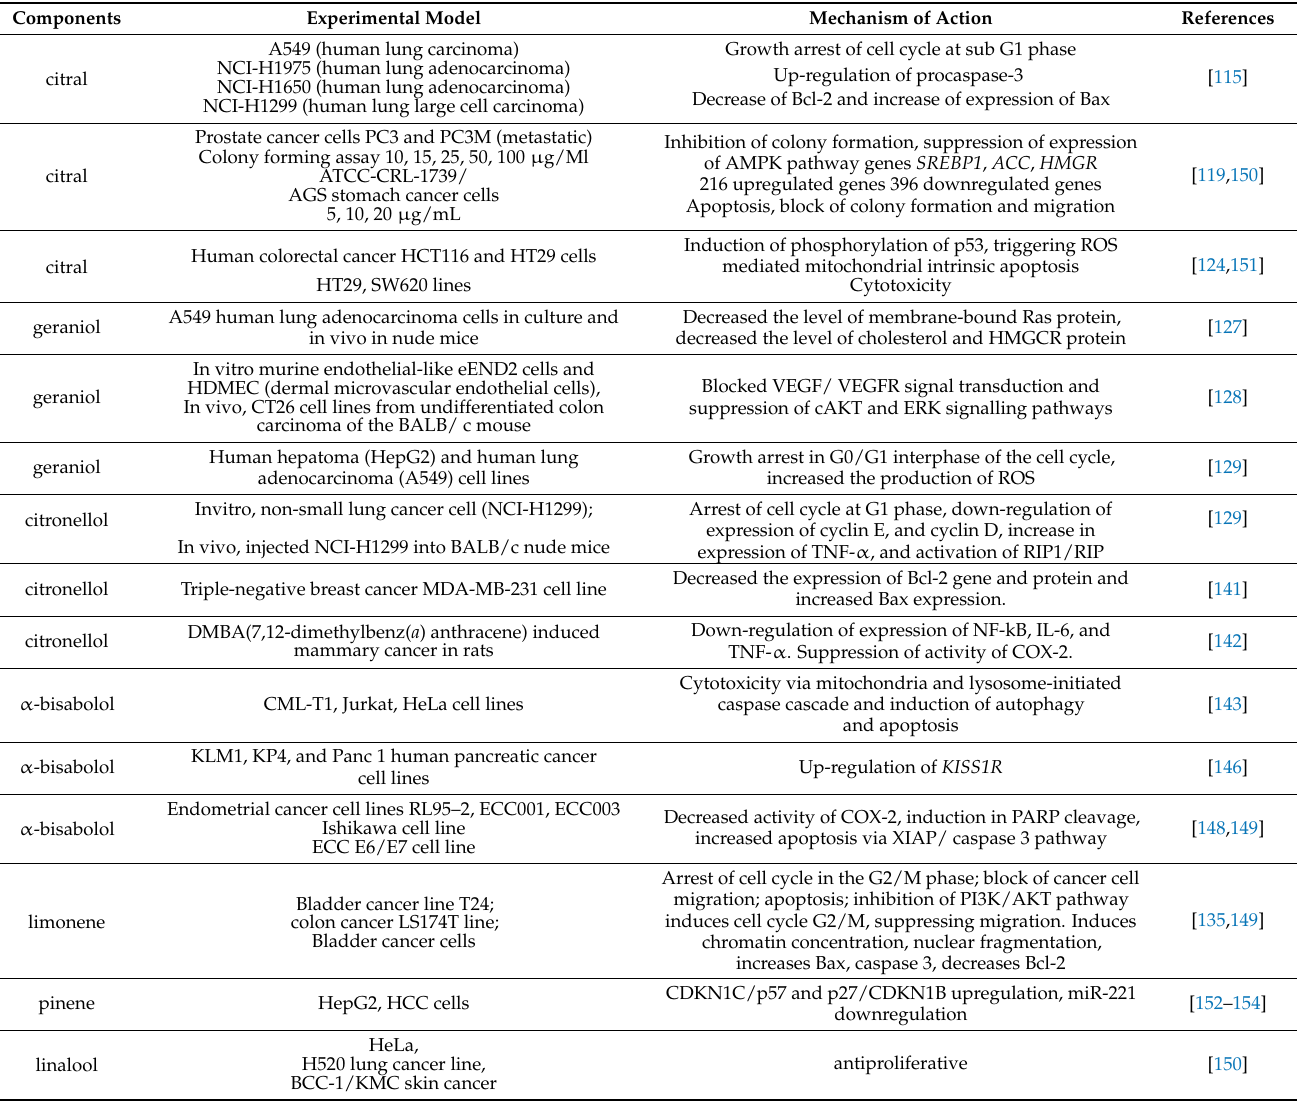
Table 5. Effects of different components of lemongrass essential oil on various cancer cell